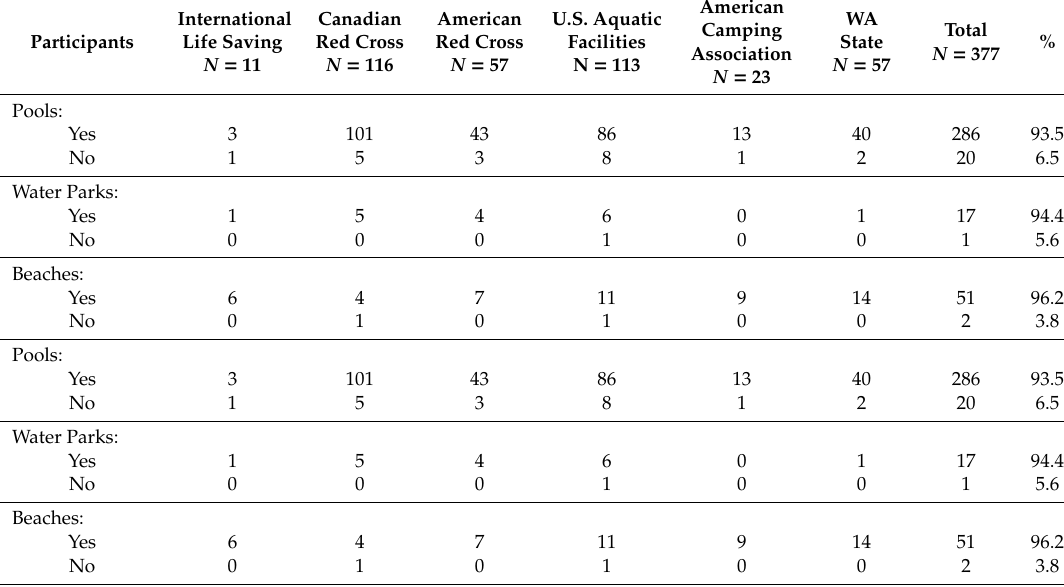
Table 2. Clothing for modesty purposes that covers the entire body is allowed? Responses by facility types of lead organizations /